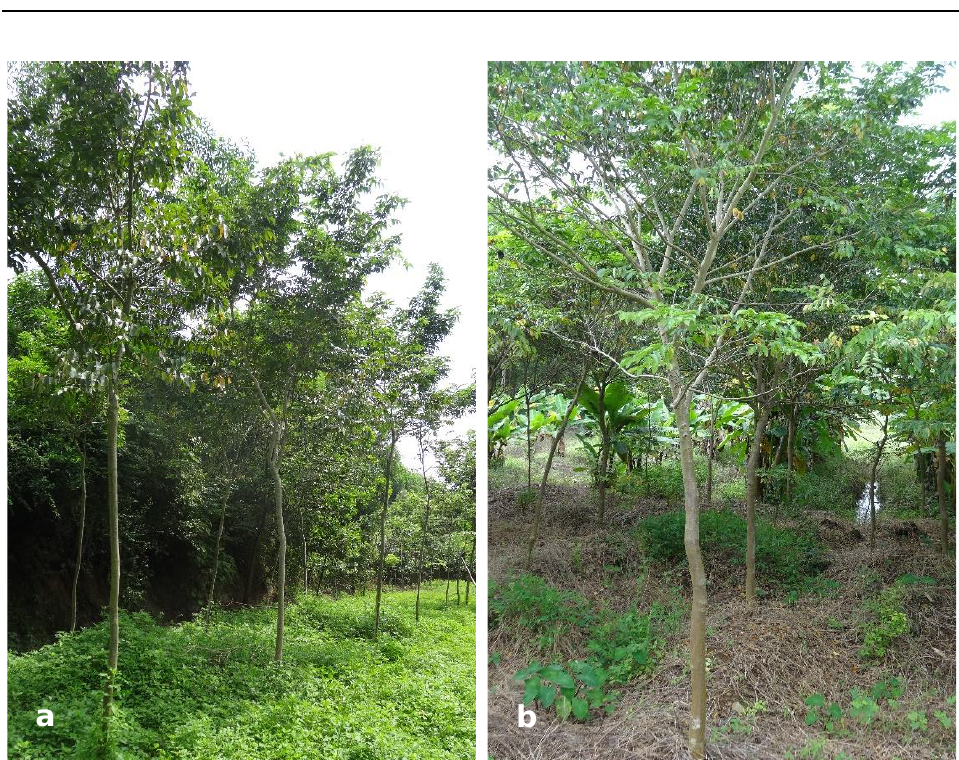
Figure 4. Three-year-old D. tonkinensis planted in Doan Hung: ( a ) superior family from Vinh Phuc; ( b ) superior family from Hanoi.